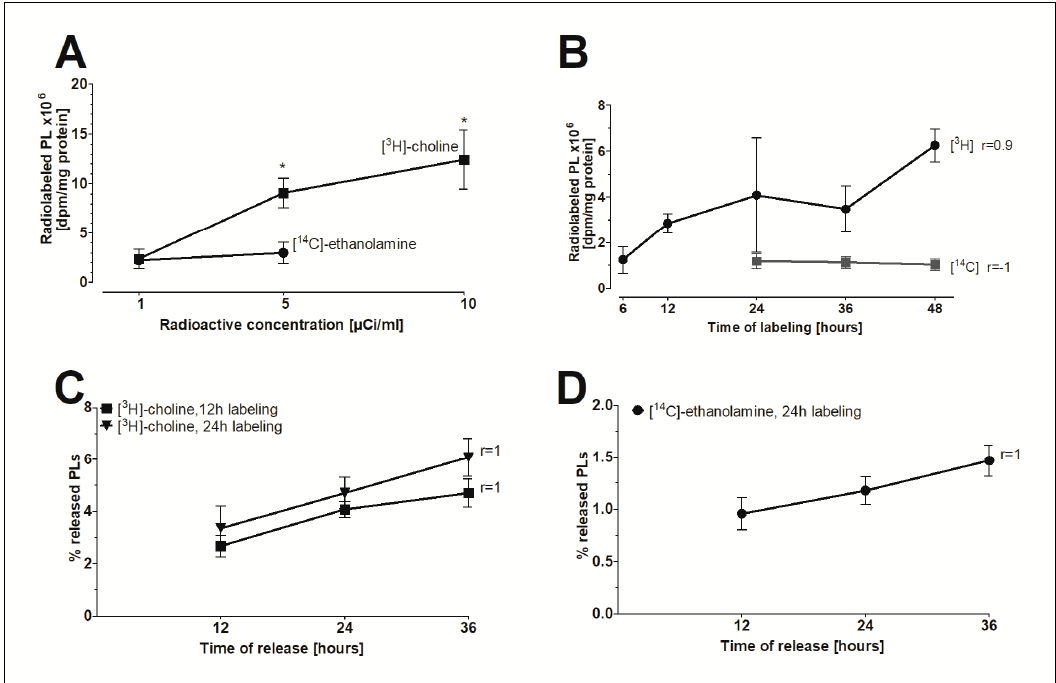
Figure 4. The in vitro model of FLS to study the release of PLs. ( A ) The concentration-dependent effect and ( B ) the time-dependent effect of the incorporation of radioactive precursors into the PLs of FLS. ( C ) The release of [ 3 H]-choline-labeled PLs and ( D ) [ 14 C]-ethanolamine-labeled PLs from FLS into media as a function of time. FLS were initially labeled with 5 µCi/mL of [ 3 H]-choline and 1 µCi/mL of [ 14 C]-ethanolamine for 12 and/or 24 h. The release of radiolabeled PLs into media with 2% FBS was then monitored during a 12–36 h period. The dpm-values were normalized to the cellular protein content. Data shown represent the percentages of released radiolabeled PLs from total radiolabeled PLs as found in media and cellular lysates. Data are presented as means ± SDs ( n = 3). * p ≤ 0.05.